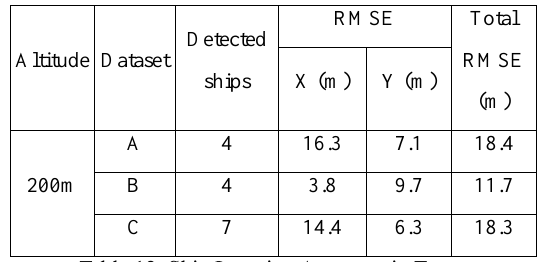
Table 12. Ship Location Accuracy in